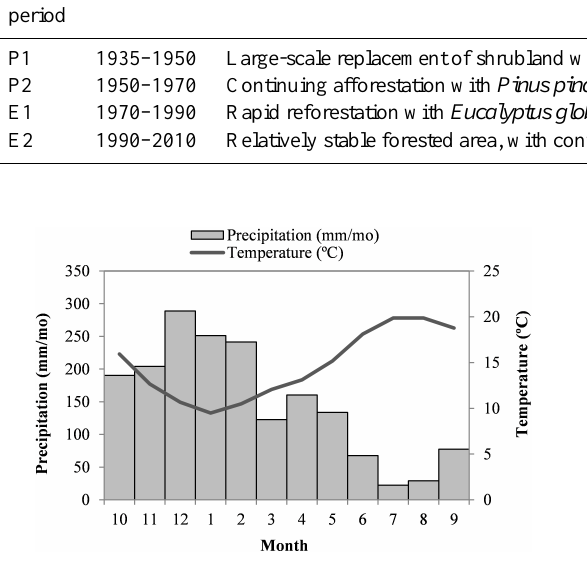
Figure 3. Burned area in the Águeda watershed from 1975 to 2010; total watershed area is 404km 2